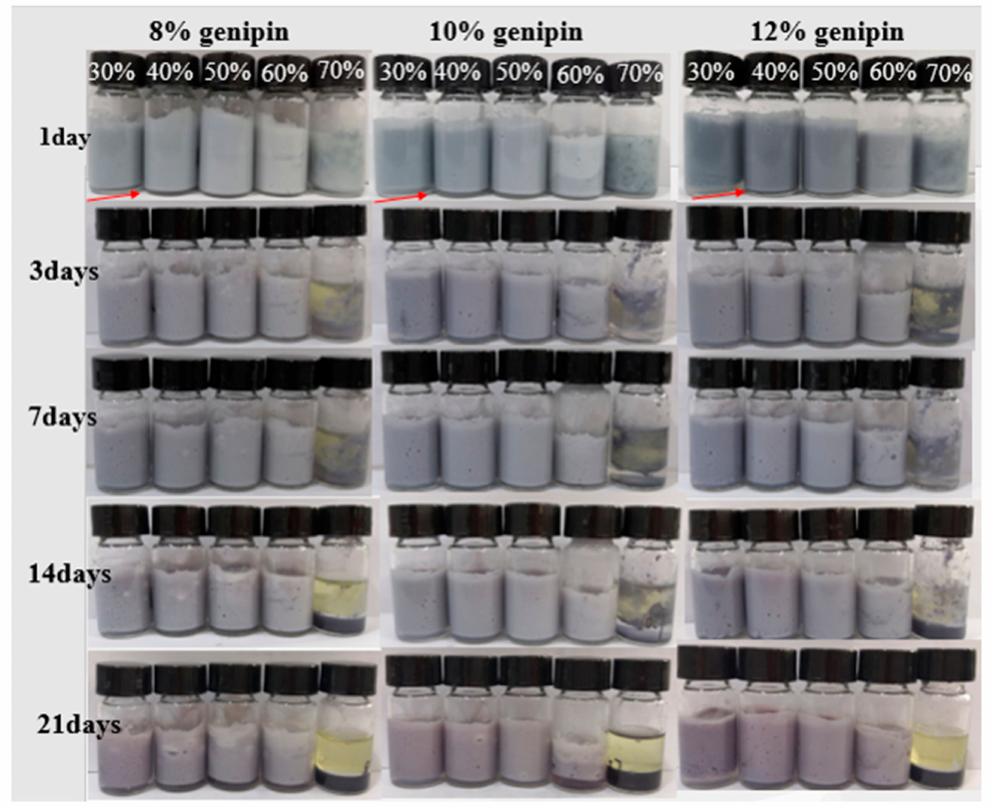
Figure 8. Photograph of Pickering emulsions stabilized by 1 wt% GNPs cross-linked by di ff erent genipin dosages (8–12 wt%) at di ff erent oil phase volumes (30, 40, 50, 60, and 70 vol%) and storage time at 4 ◦ C (1, 3, 7, 14, and 30